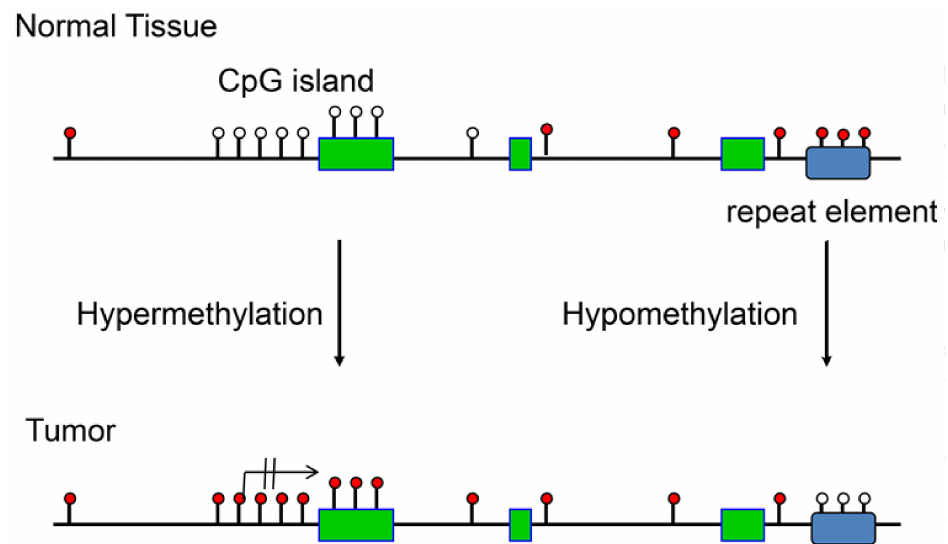
Figure 1. Schematic outline of the most relevant DNA methylation changes observed in human cancers. These events include CpG-island-specific DNA hypermethylation often occurring at gene promoters, which locks the affected gene into an inactive state. Loss of DNA methylation (hypomethylation) occurs genome-wide and is often observed at repetitive regions of the genome. White circles indicate unmethylated CpG sites and red circles show methylated CpG sites. The crossed-out arrow indicates the transcription start site and the permanent lack of transcription after DNA methylation. Green boxes show exons and the blue rectangle marks the position of a repetitive